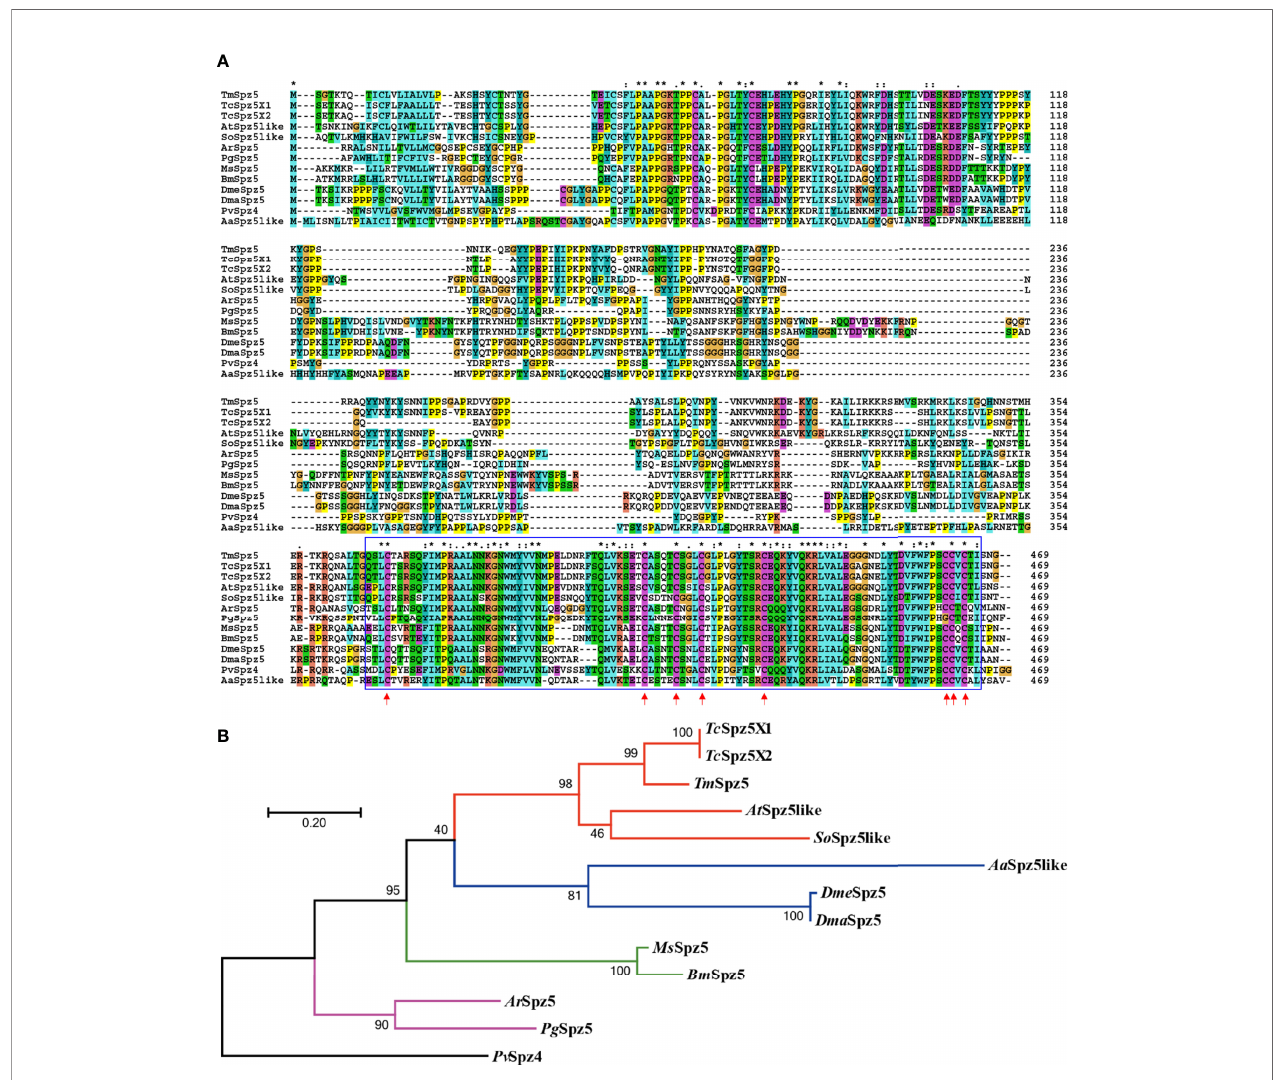
FIGURE 2 | Multiple-sequence alignment (A) and phylogenetic analysis (B) of T. molitor Spätzle5 ( Tm Spz5). A domain analysis was performed using ClustalX2, and the phylogenetic tree was constructed using MEGA7 with the maximum likelihood method and 1,000 bootstrap replicates (where numbers at nodes indicate bootstrap support). The representative Spätzle 5 protein sequences showed high homology at the conserved domains marked in blue boxes, and the red arrows indicate conserved cystine-knot domain scores between groups. A neighbor-joining (NJ) tree was constructed based on the protein sequences of Tc Spz5, Tribolium castaneum spätzle 5 isoform X1 (XP_008193940.1); Tc Spz5, Tribolium castaneum spätzle 5 isoform X2 (XP_015836109.1); At Spz5like, A . tumida spätzle 5-like (XP_019879590.1); So Spz5like, S. oryzae spätzle 5-like (XP_030767938.1); Ms Spz5, M. sexta spätzle 5 (XP_037299529.1); Bm Spz5, B . mori spätzle 5 (XP_004924790.1); Aa Spz5like, A . albimanus spätzle 5-like (XP_035790066.1); Dme Spz5, D . melanogaster spaetzle5 (NP_647753.1); Dma Spz5, D . mauritiana spätzle 5 (XP_033160799.1); Ar Spz5, A . rosae spätzle 5 (XP_012261687.1); Pg Spz5, P. gracilis spätzle 5 isoform X3 (XP_020284715.1); and Pv Spz4, P. vannamei spätzle 4 (ANJ04742.1) which was used as the outgroup. Colored lines indicate different insect orders; red: Coleopteran, green: Lepidopteran, blue: Dipteran, purple: Hymenopteran. Pv Spz4, illustrated black, belongs to the Crustacean